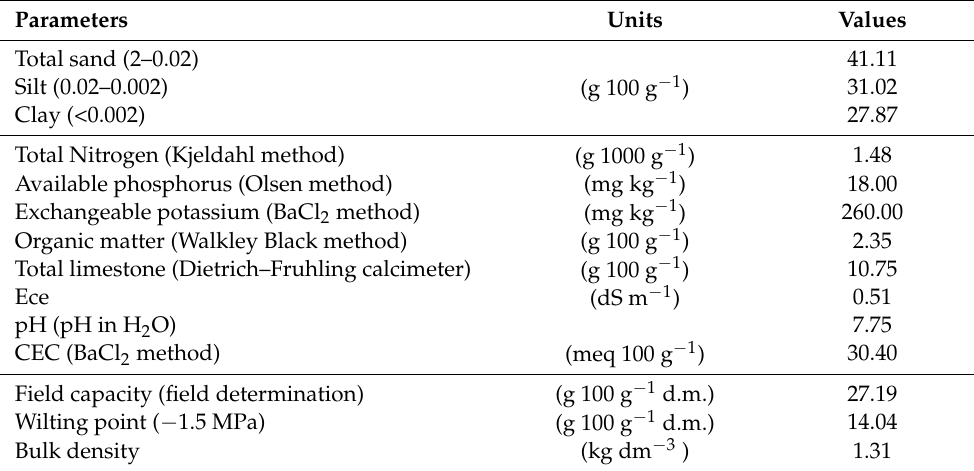
Table 3. Main physico-chemical and hydrologic proprieties of the